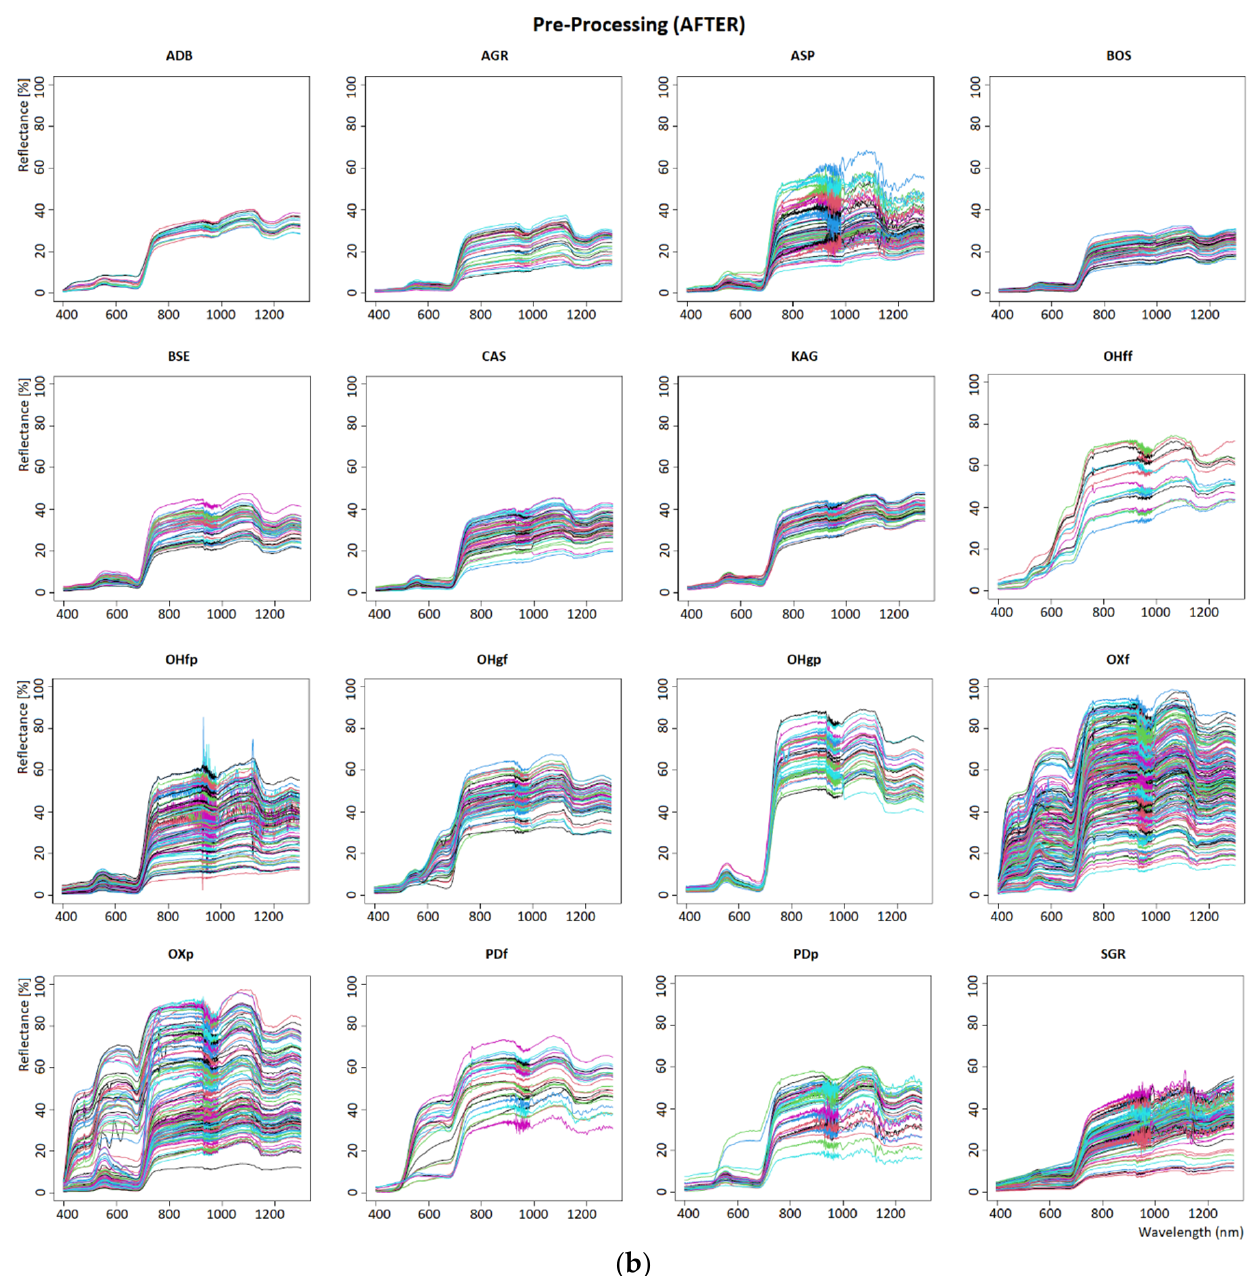
Figure 4. Spectral profiles of ( a ) pre- and ( b ) post-outlier removal processing for the plant samples collected by the spec- troradiometer with optical lens in the first survey in 2017.